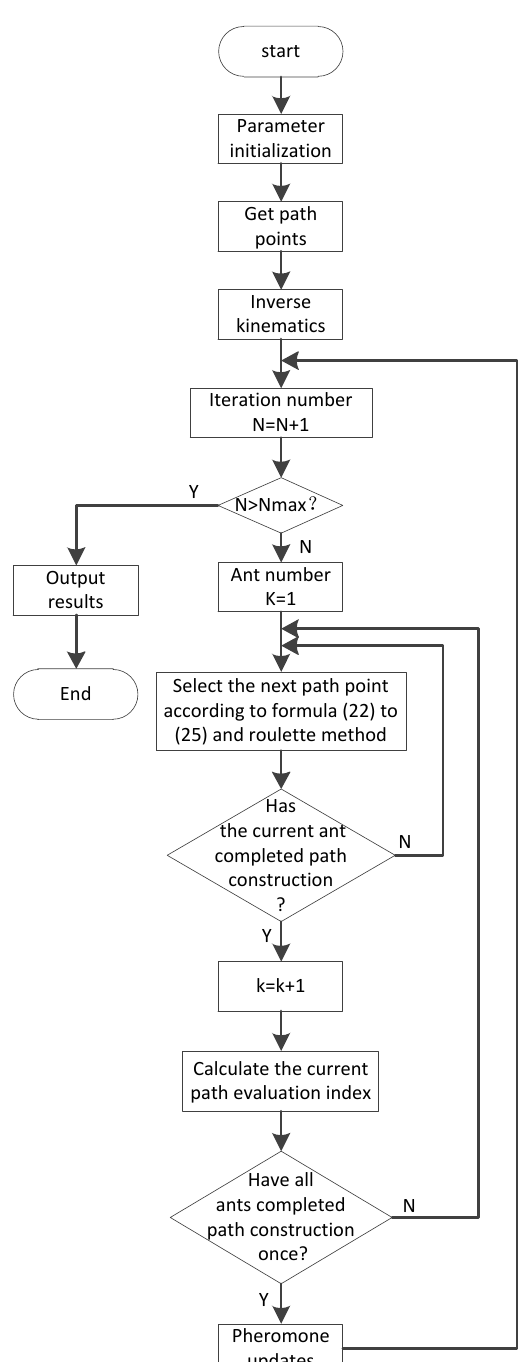
Figure 5. Overall algorithm flowchart.